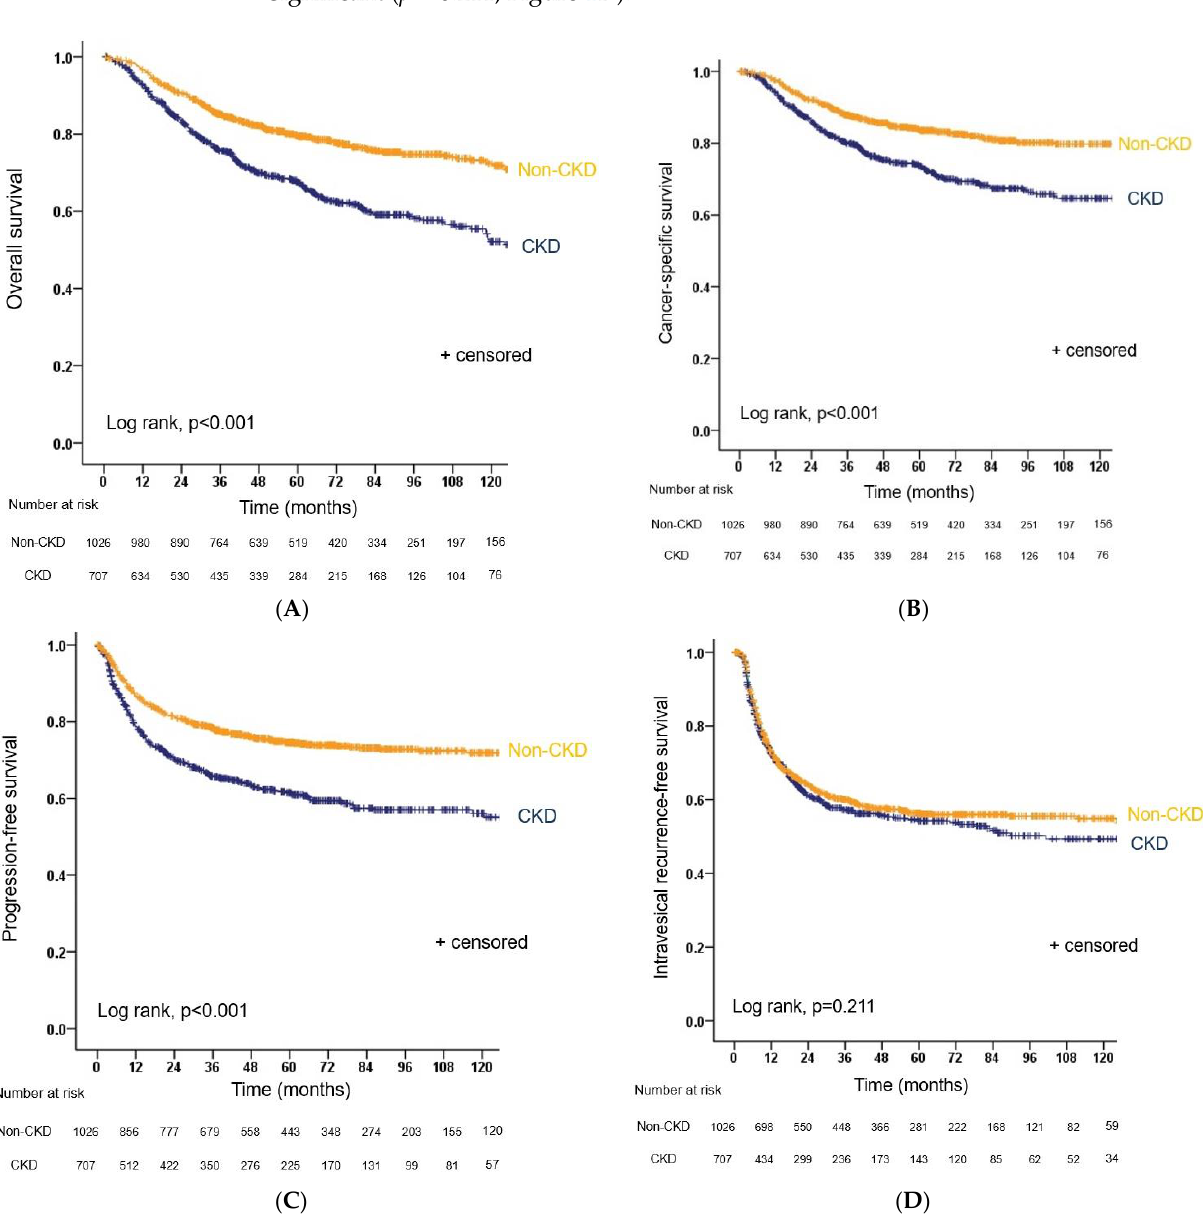
Table 2. Multivariable Cox proportional hazard regression analyses to predict death from all-cause, death from upper tract urothelial carcinoma, progression, and intravesical tumor recurrence in 1733 patients with upper tract urothelial carcinoma treated with radical nephroureterectomy.